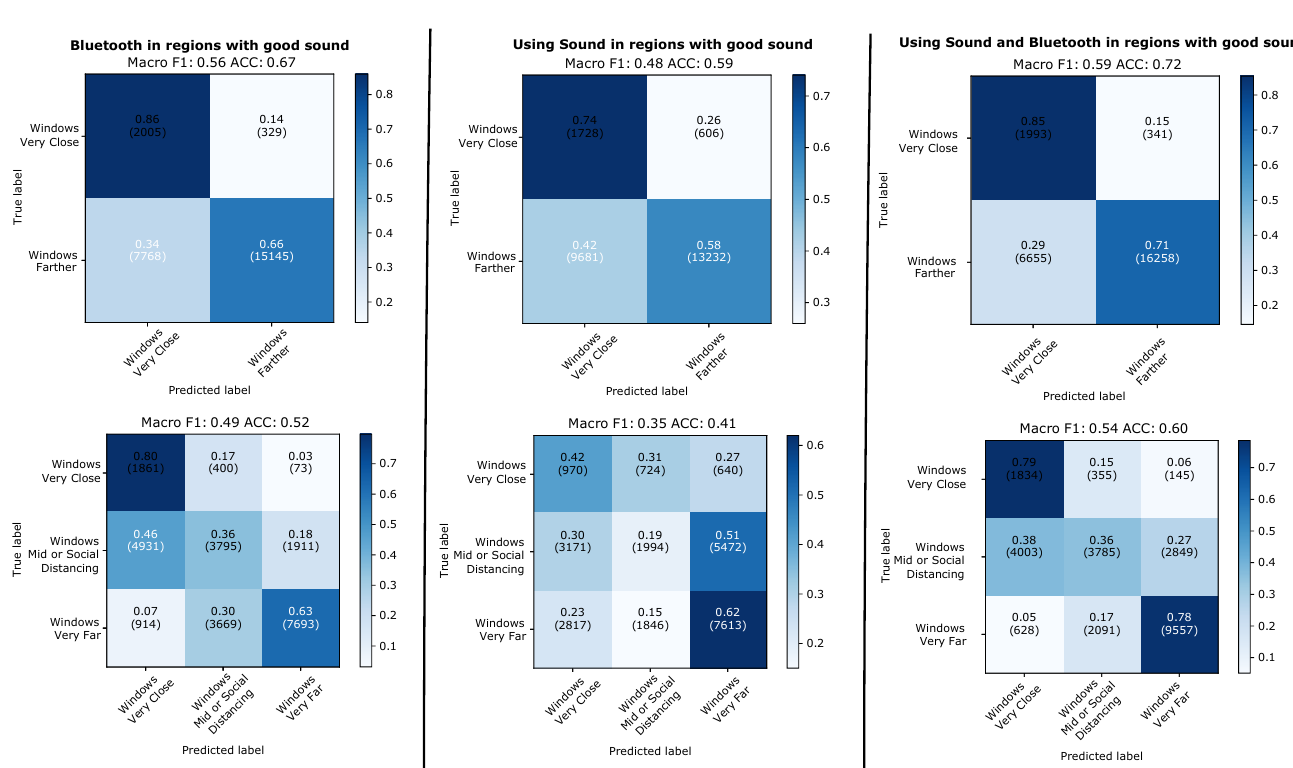
Figure 12. Evaluation across types of days. Results for evaluation when predicting individual 5 s windows with good